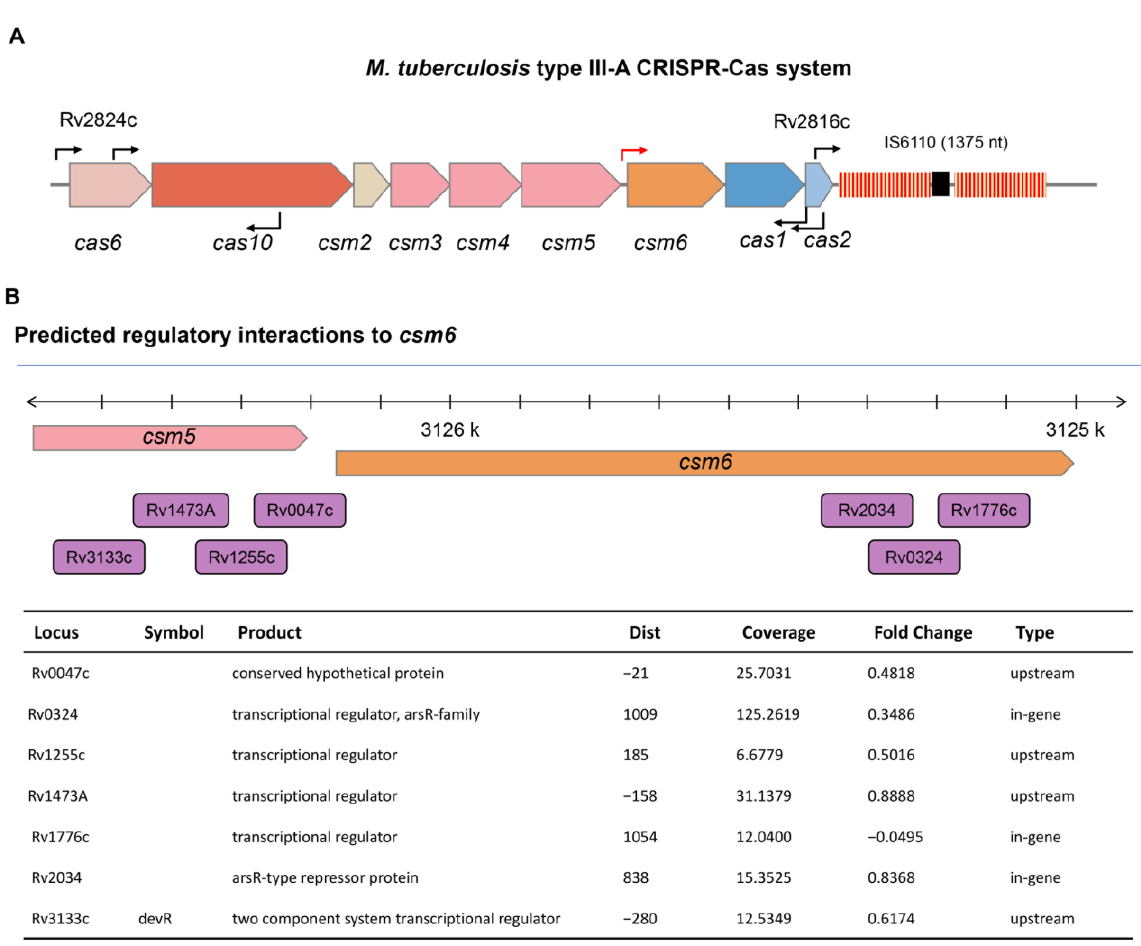
Figure 1. Type III-A CRISPR system of M. tuberculosis . ( A ) Genetic organization of the CRISPR-Cas system in M. tuberculosis . In M. tuberculosis , the CRISPR-Cas system is a type III-A system, and the expression pattern may differ from that of other cas genes. An independent transcription start site (TSS) was identified upstream of the gene csm6 (red arrow) . The TSS of other genes are indicated with black arrows in the schematic. ( B ) Predicted transcription factors interacting with Csm6 . The blocks in purple refer to the predicted transcription factors, and the locations indicate the maximum coverage of possible binding sites. Fold change is the expression of a target gene ( csm6 ) when the corresponding transcription factor is induced, as noted in the TB database. Binding types are either genic or intergenic, based on the location of maximum coverage for the binding site relative to predicted genes.